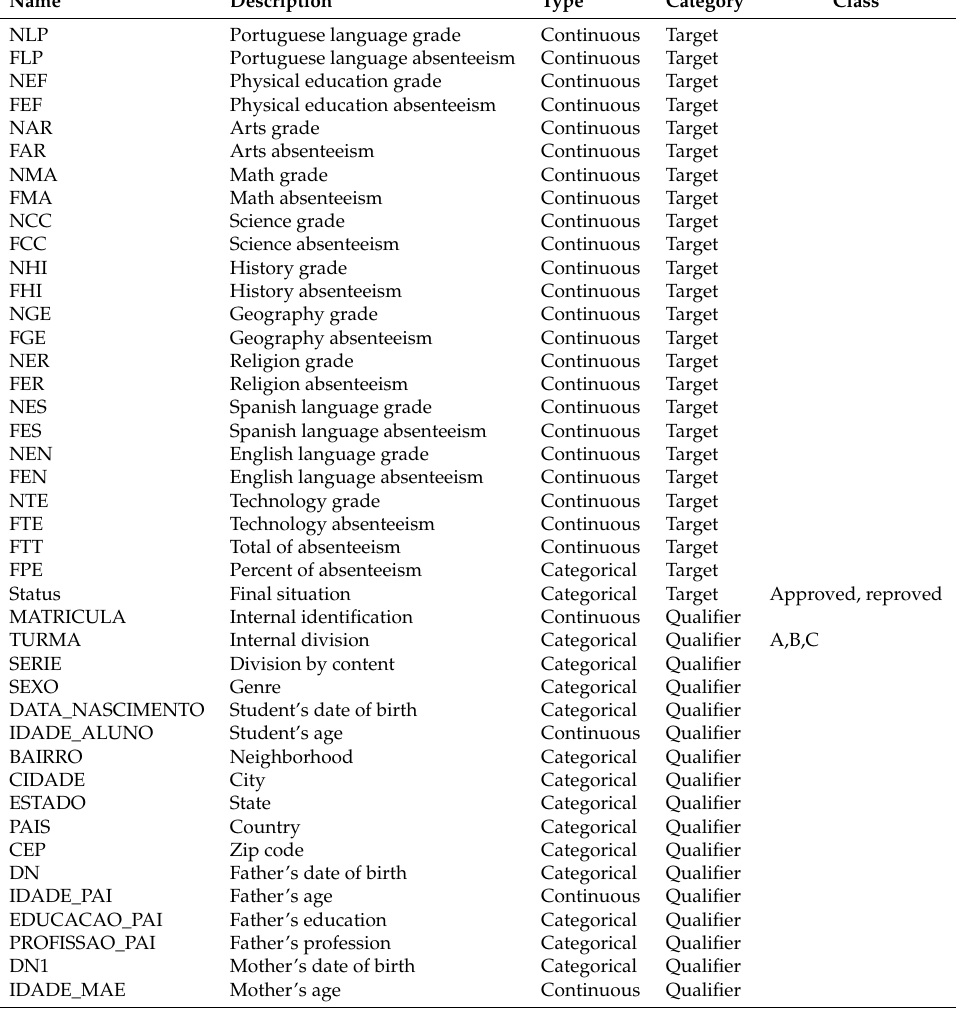
Table 7. Dataset and attribute types. These attributes are used to explain images from 7 until